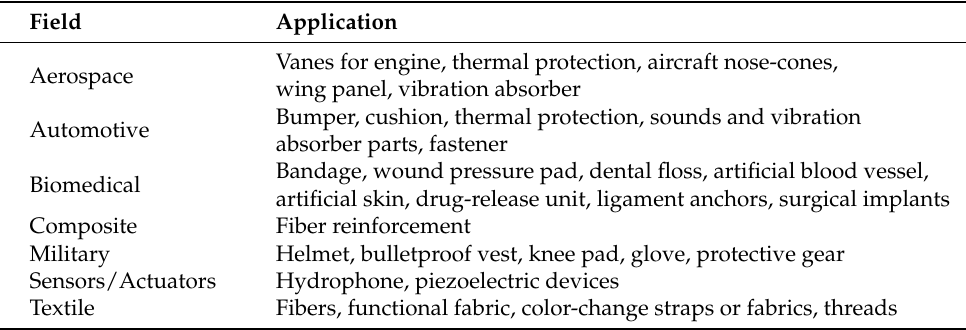
Table 2. Summary of the main applications for auxetic materials